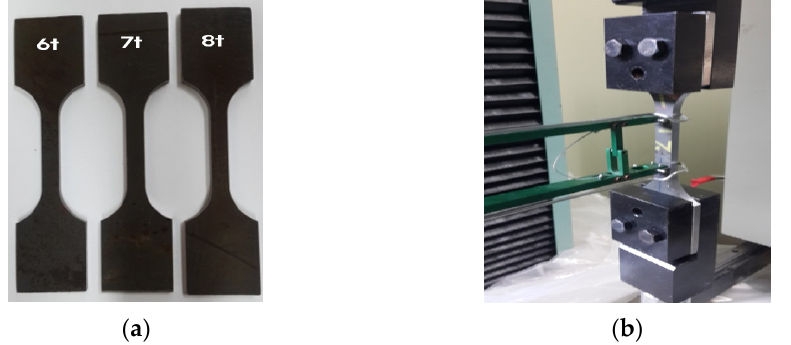
Figure 2 . ( a ) The representative tensile testing specimens with three different thickness and ( b ) image of the test jig.